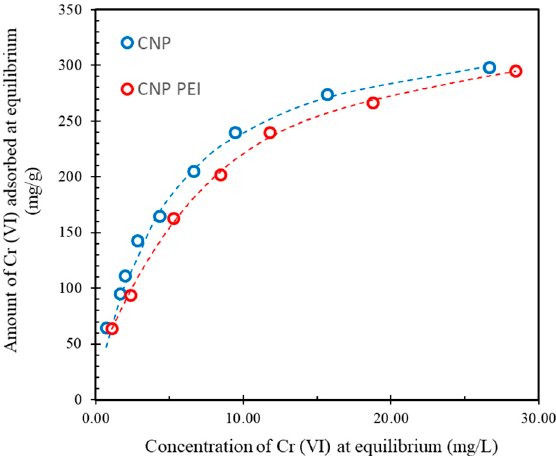
Figure 2. Langmuir isotherms for Cr (VI) adsorption on CNP and CNP PEI carbons, measured at pH 2.